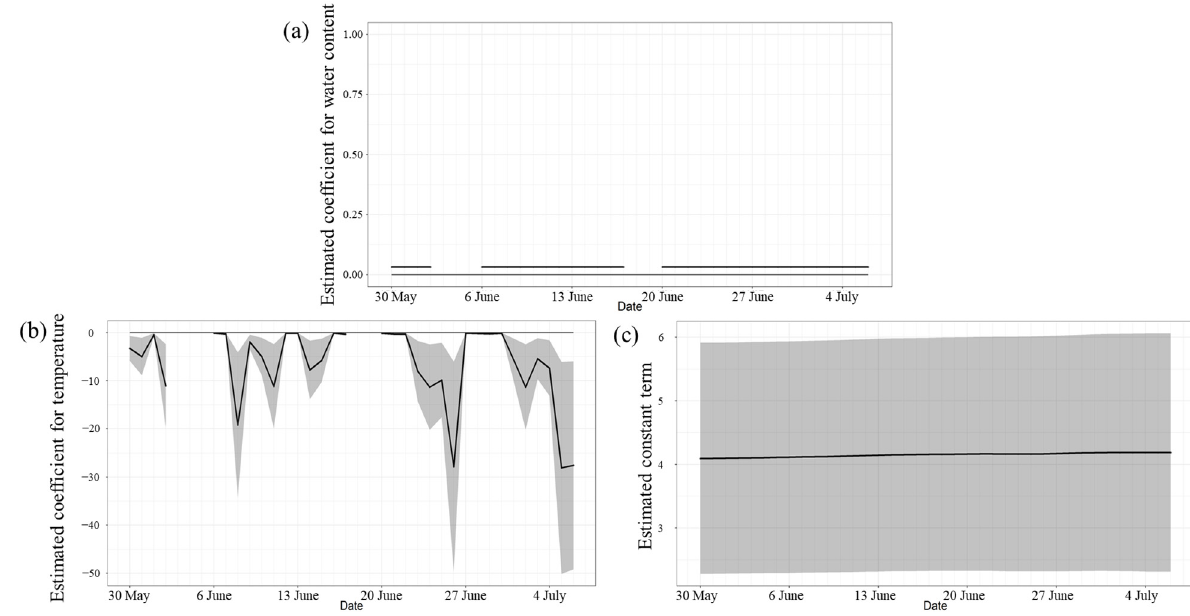
Figure 6. ( a ) Estimation of water content at Kizaki Beach. ( b ) Estimation of temperature at Kizaki Beach. ( c ) Estimation of the constant term at Kizaki Beach. The gray hatches in the figures indicate the 95% con fi dence intervals of the estimated values.